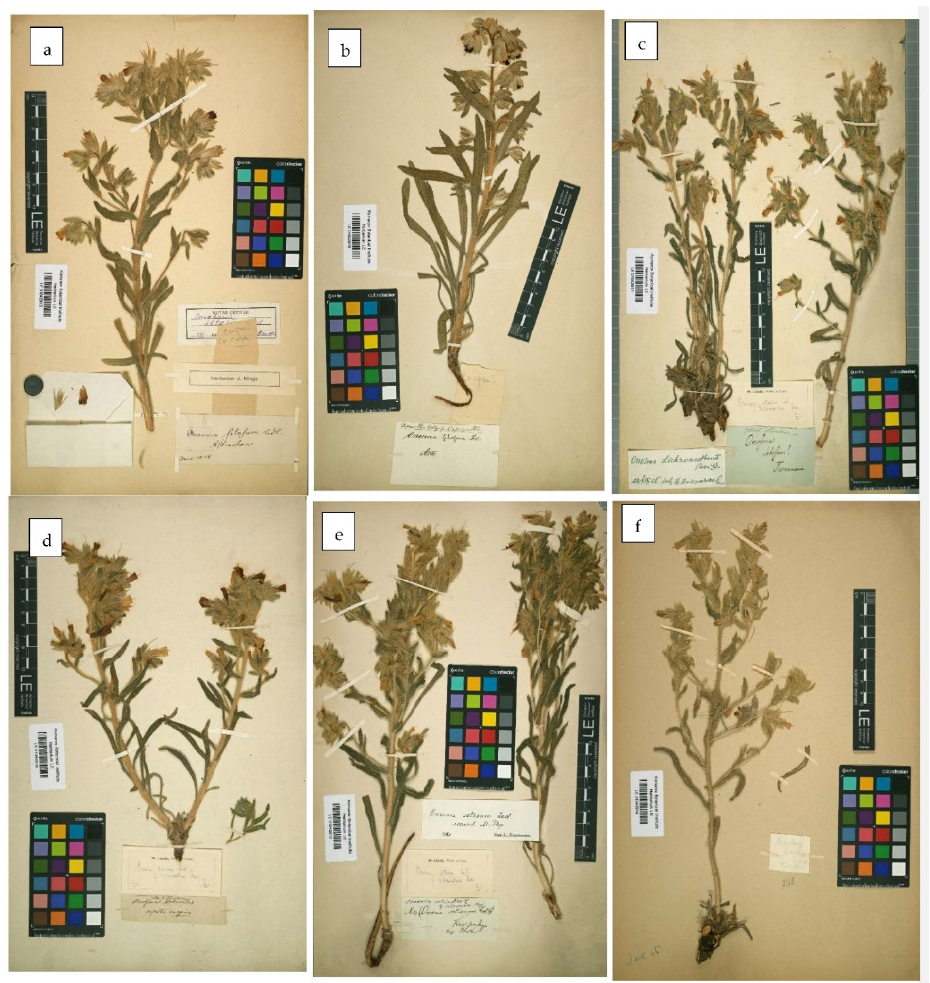
Figure 3. The specimens of O. setosa Ledeb. from the LE Herbarium: ( a ) LE (LE 01042913), ( b ) LE (LE 01042915), ( c ) LE (LE 01042911), ( d ) LE (LE 01042916), ( e ) LE (LE 01042912), ( f ) LE (LE 01042914).